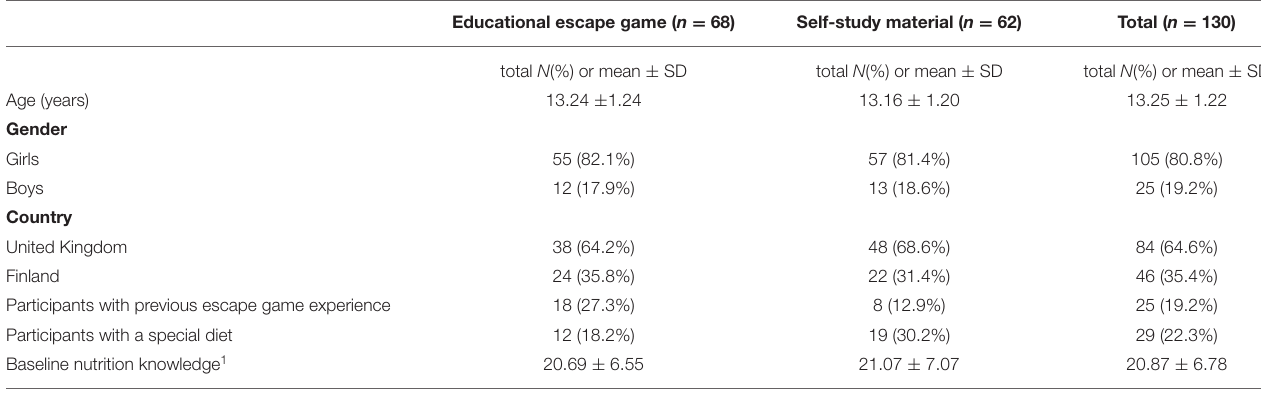
TABLE 1 | Baseline data by intervention condition.